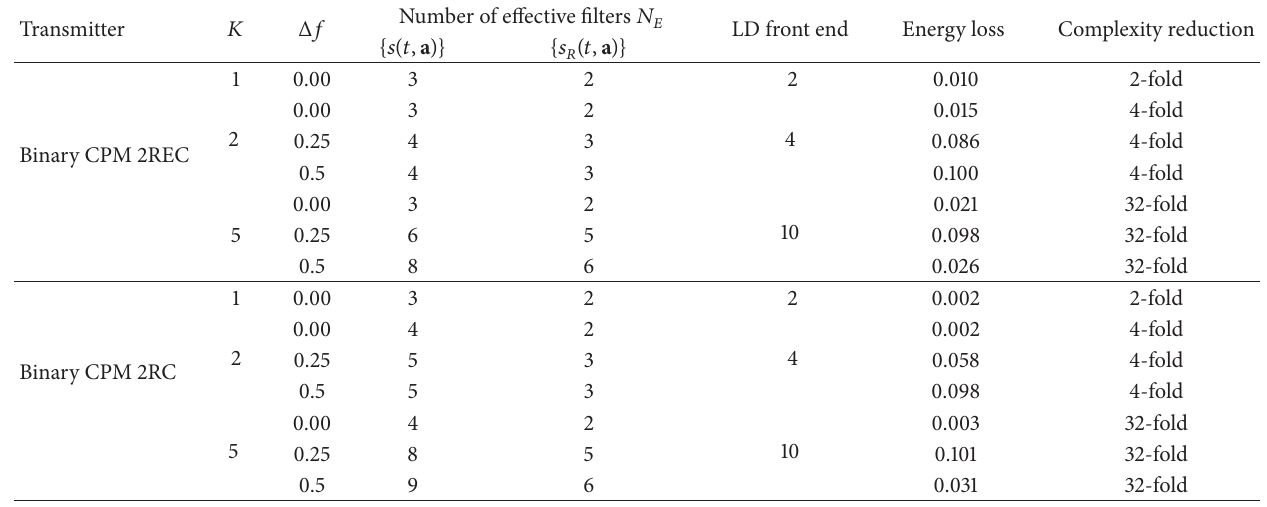
Table 1: Comparison and performance analysis of some MSK-based receivers.